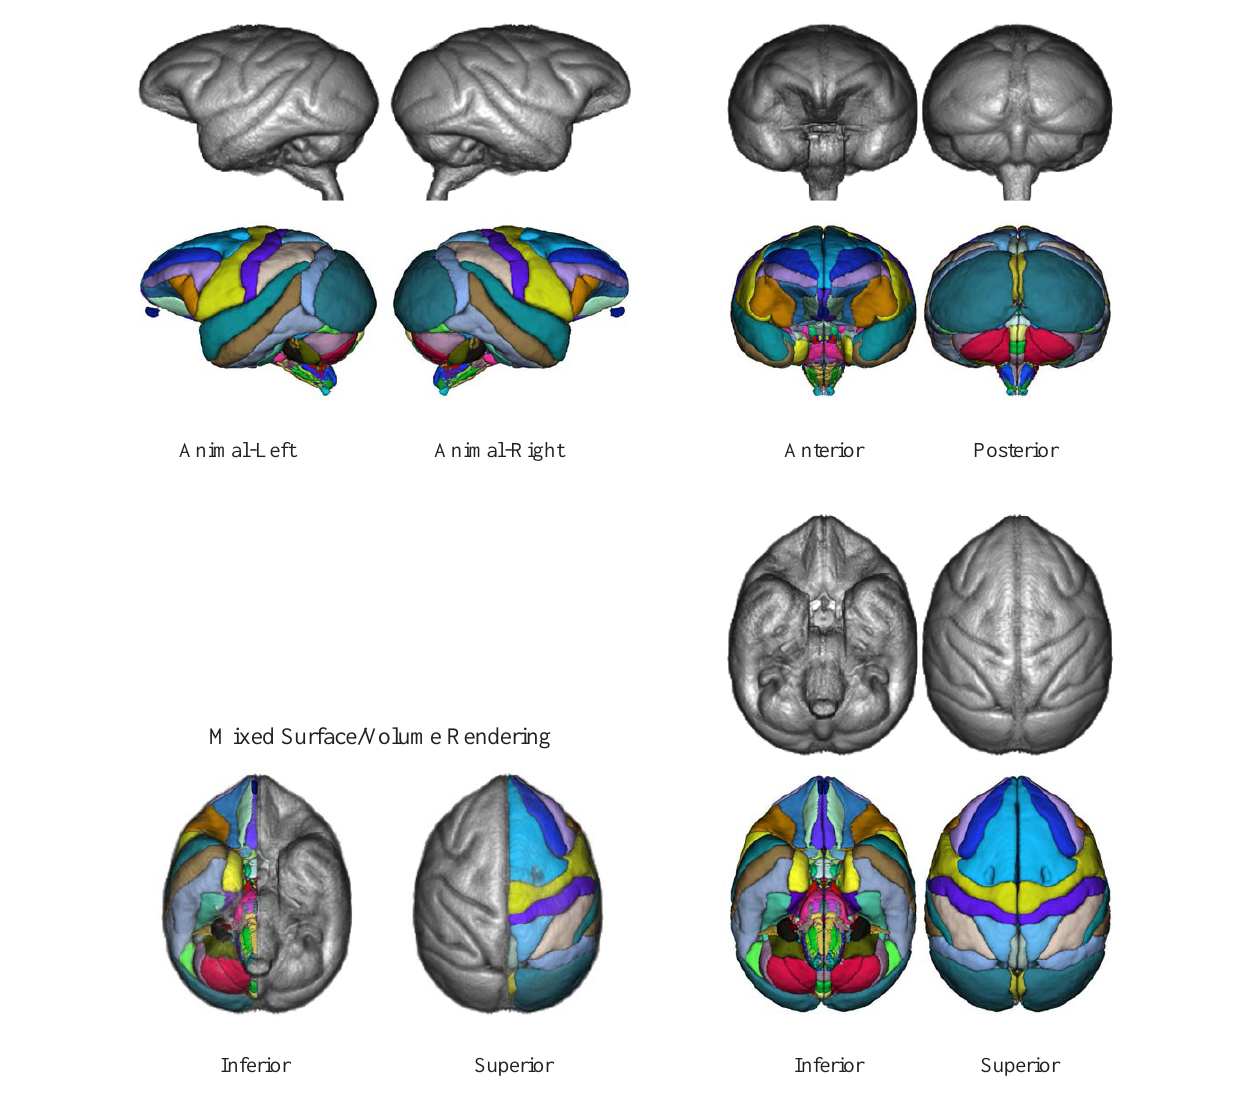
FIGURE 7 |Three-dimensional volume renderings of theT1-weighted INIA19 brain template image (gray) and surface renderings of the NeuroMaps label map (colors) after mapping into INIA19 coordinate